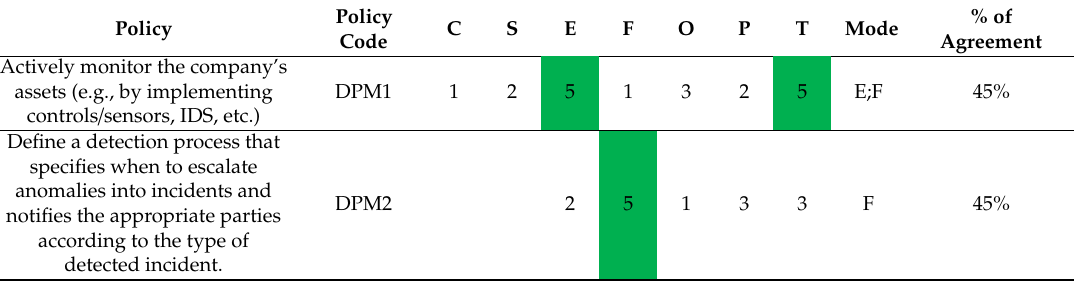
Table 24. Detection processes and continuous monitoring policies’ progression